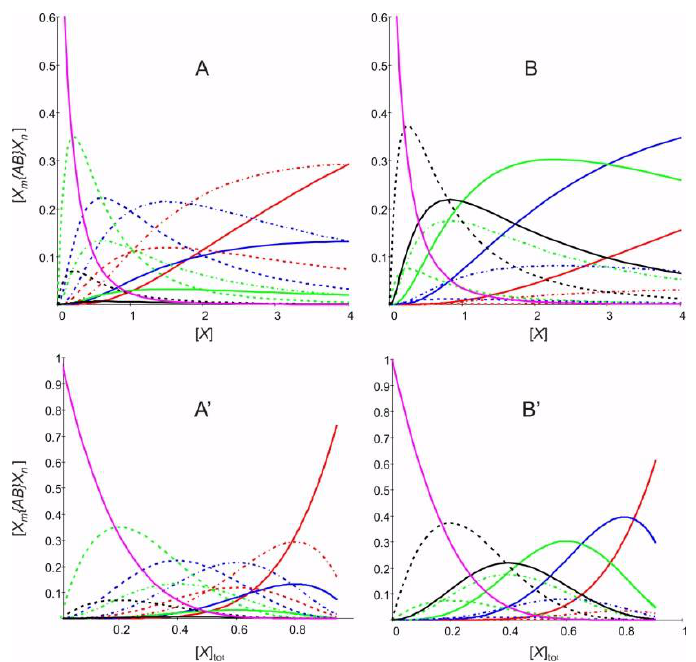
Figure A1. Concentration of X m { AB } X n as a function of the concentration of X , ( A , B ), and versus the total concentration [ X ] tot of X in the system, ( A’ , B’ ). ( A , A’ ) calculated for K 1 = 5.0 and K 10 = 1.0; ( B , B’ ) calculated for K 1 = 1.0 and K 10 = 5.0. Red lines: [ X 3 { AB } X n ] (solid: n = 2, dash: n = 1, dash dot: n = 0). Blue lines: [ X 2 { AB } X n ] (solid: n = 2, dash: n = 1, dash dot: n = 0). Green lines: [ X { AB } X n ] (solid: n = 2, dash: n = 1, dash dot: n = 0). Black lines: [{ AB } X 2 ] solid: [{ AB } X ] dash. Pink line: [{ AB }] = C 12 (solid).